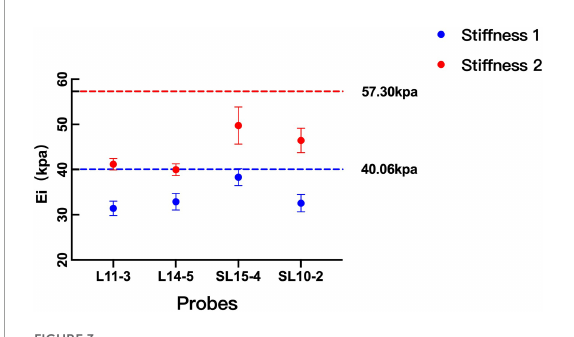
FIGURE3 Comparison between the measurement values among probes. The measurements on both probes were lower than the theoretical values of the two kinds of stiffness. With the increase in the stiffness of the phantom, the difference between machines becomes significant.